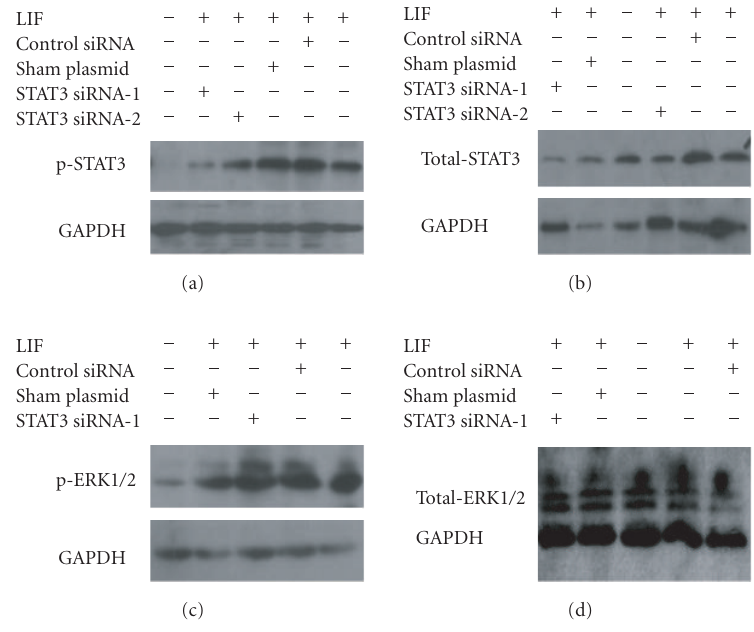
Figure 5: E ff ects of siRNA(STAT3) on LIF-induced activation of signal transduction and activation of transcription (STAT3) and ERK1/2 . Western blot was performed on NHBE cells that had been preincubated with or without siRNA(STAT3) and then stimulated with LIF. (a) LIF induced activation of tyrosine phosphorylation of STAT3, and tyrosine phosphorylation of STAT3 was inhibited by siRNA-1 and siRNA-2, but neither by control siRNA nor sham plasmid. (b) Similiar to phosphorylation of STAT3, total-STAT3 was inhibited by siRNA- 1 and siRNA-2, but neither by control siRNA nor sham plasmid. (c) LIF induced activation of phosphorylation of ERK1/2, but ERK1/2 activation was not inhibited by siRNA-1 against STAT3. (d) Similiar to phosphorylation of ERK1/2, the expression of total-ERK1/2 was not a ff ected by siRNA-1 against STAT3. Experiments were repeated three times with similar results, and the data was expressed as the mean ratio(target/GAPDH) ±